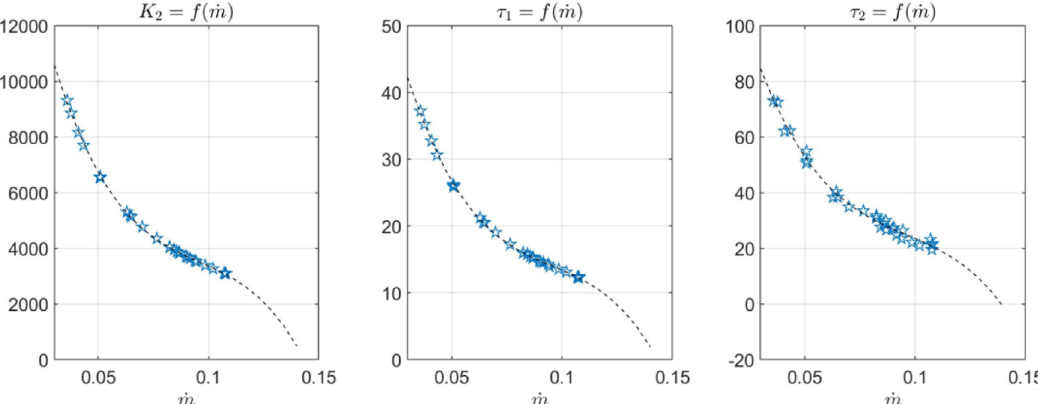
Fig. 7. Polynomial dependencies of the process model parameters in equation (3). Stars indicate measured data-points, dashed line is the estimated polynomial of 3rd order.